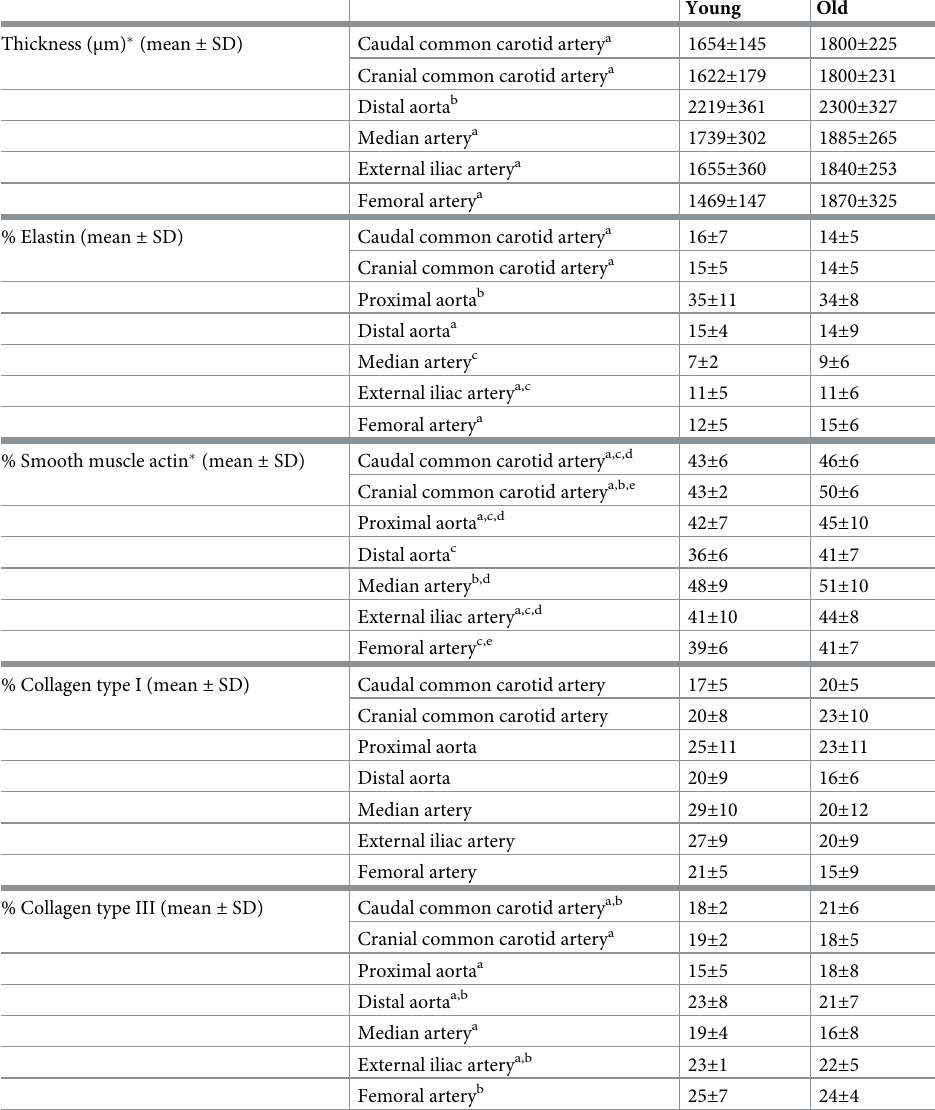
Table 1. Overview of overall measured intima media thickness, area % of elastin, smooth muscle actin, collagen type I and collagen type III for the caudal and cranial common carotid artery, the proximal and distal aorta, the median, the external iliac and the femoral artery in old and young horses.